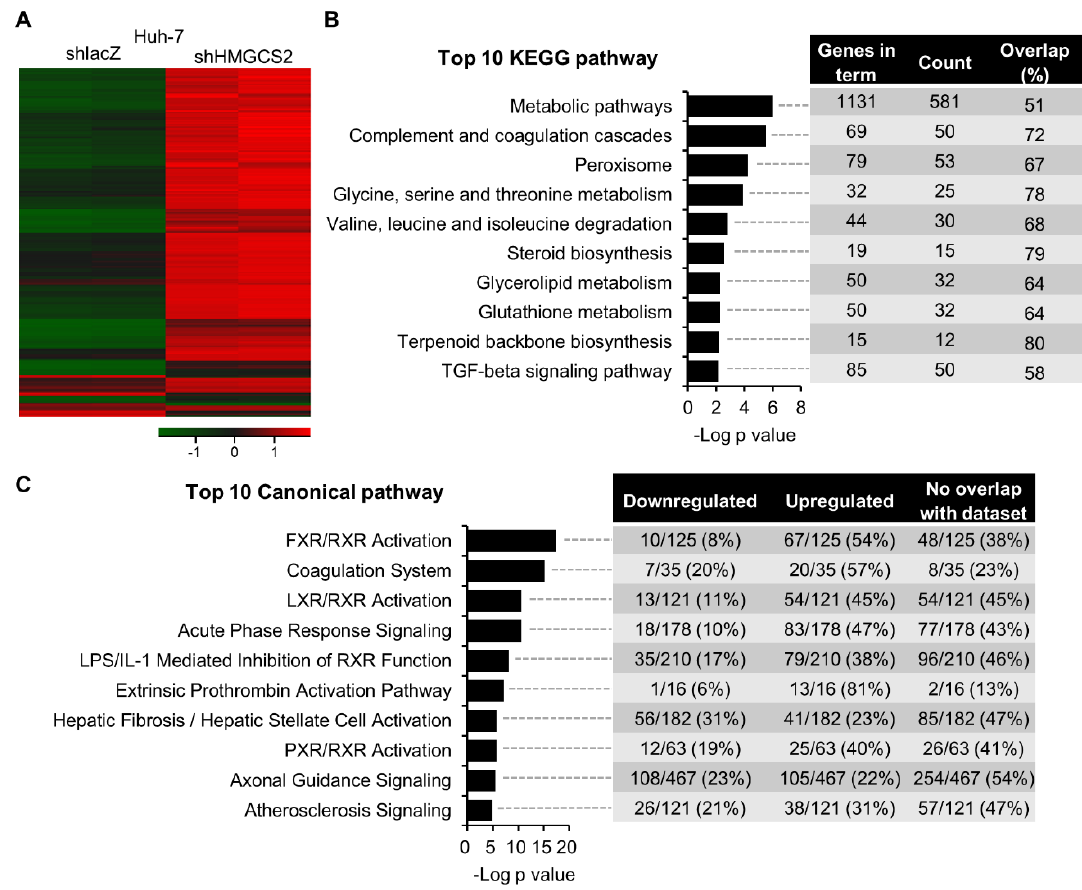
Figure 2. Detailed gene expression profile of HMGCS2 knockdown Huh-7 cells. ( A ) Heat map of the mRNA expression profile of shlacZ and shHMGCS2 cells based on mRNA microarray analysis. The differential expression of genes listed in the hierarchical clustering map was defined by the ratio of the expression in shHMGCS2 cells to that in shlacZ control cells as a log2 (fold change) of ≥ 2 (upregulation, red) or ≤ 0.5 (downregulation, green). ( B ) Top 10 Kyoto Encyclopedia of Genes and Genomes (KEGG) pathways. The height of the histogram corresponds to the relative expression value for a particular pathway that significantly changed. ( C ) Top 10 canonical pathways classified by IPA after HMGCS2 knockdown in Huh-7 cells.